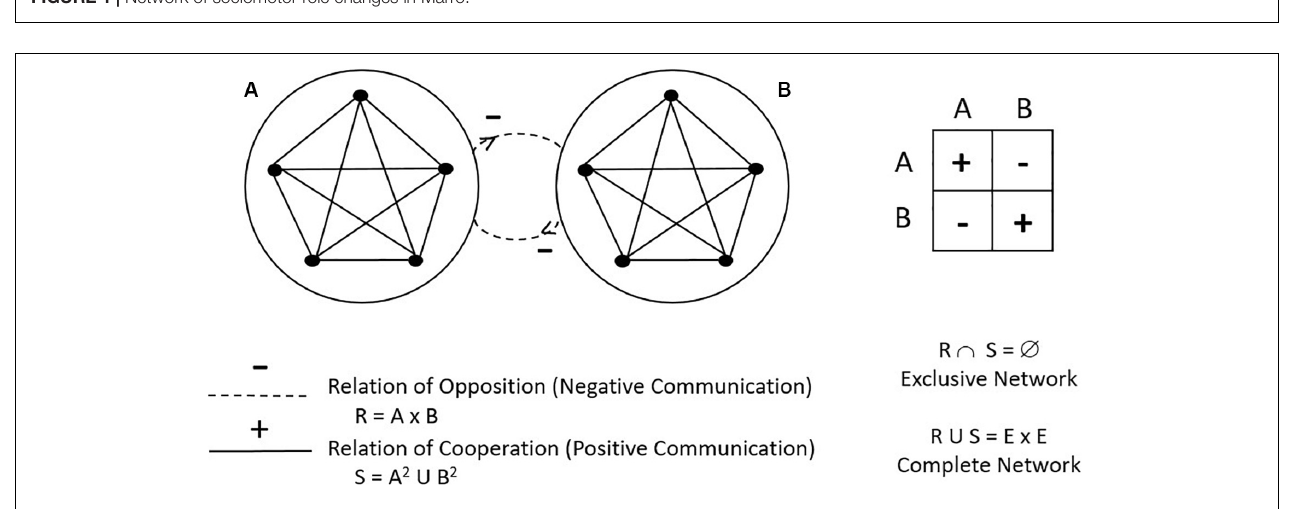
FIGURE 2 | The motor communication network in Marro